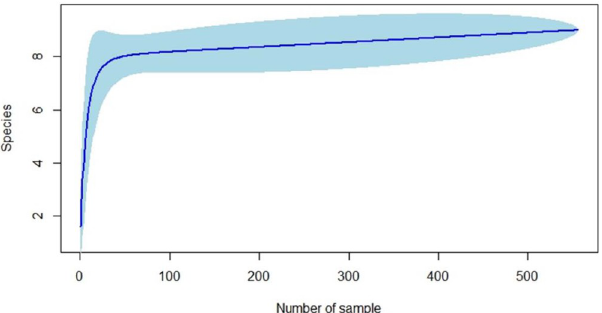
Figure 6. Species accumulation curve based on total sample